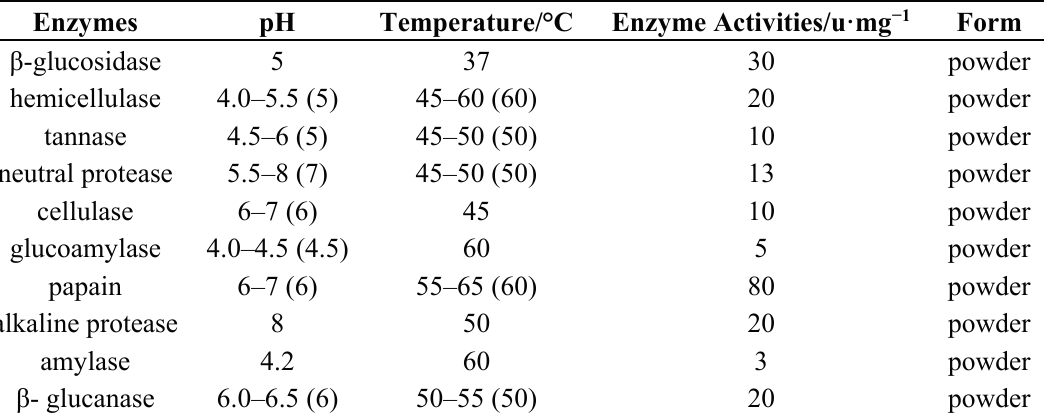
Table 5. The specific information of the different